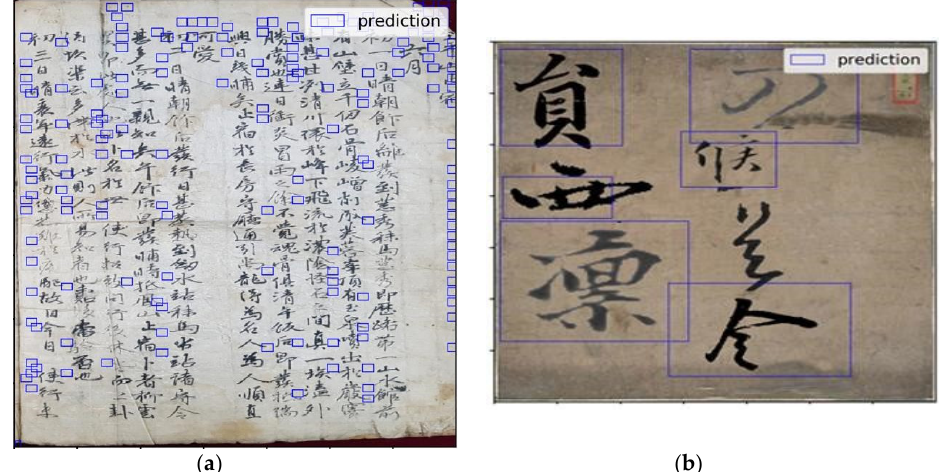
Figure 7. The results of the proposed FAN-MCCD that effectively adapts all different scales of characters in all different kind of KNU datasets. ( a ) The detection result on Caoshu dataset with dense distribution and different sized characters. ( b ) The detection result on Src-images dataset with very large multi-scale characters. ( c , d ) The result on Character dataset with a small number of various scales of characters. ( e , f ) The results with predicted bounding boxes (blue) overlaid with ground truth bounding boxes (red).